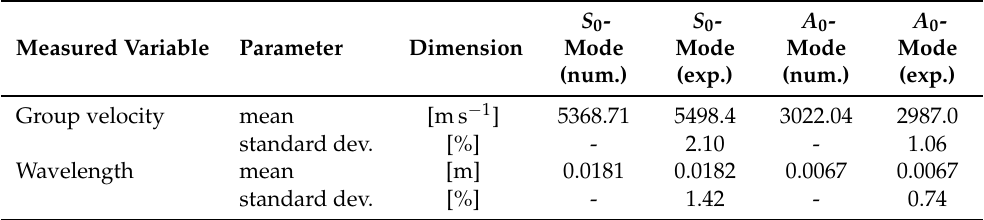
Table 2. Experimentally and numerically determined group velocities and wavelengths in the 2mm aluminum (material: 3.3535) waveguide at f c =